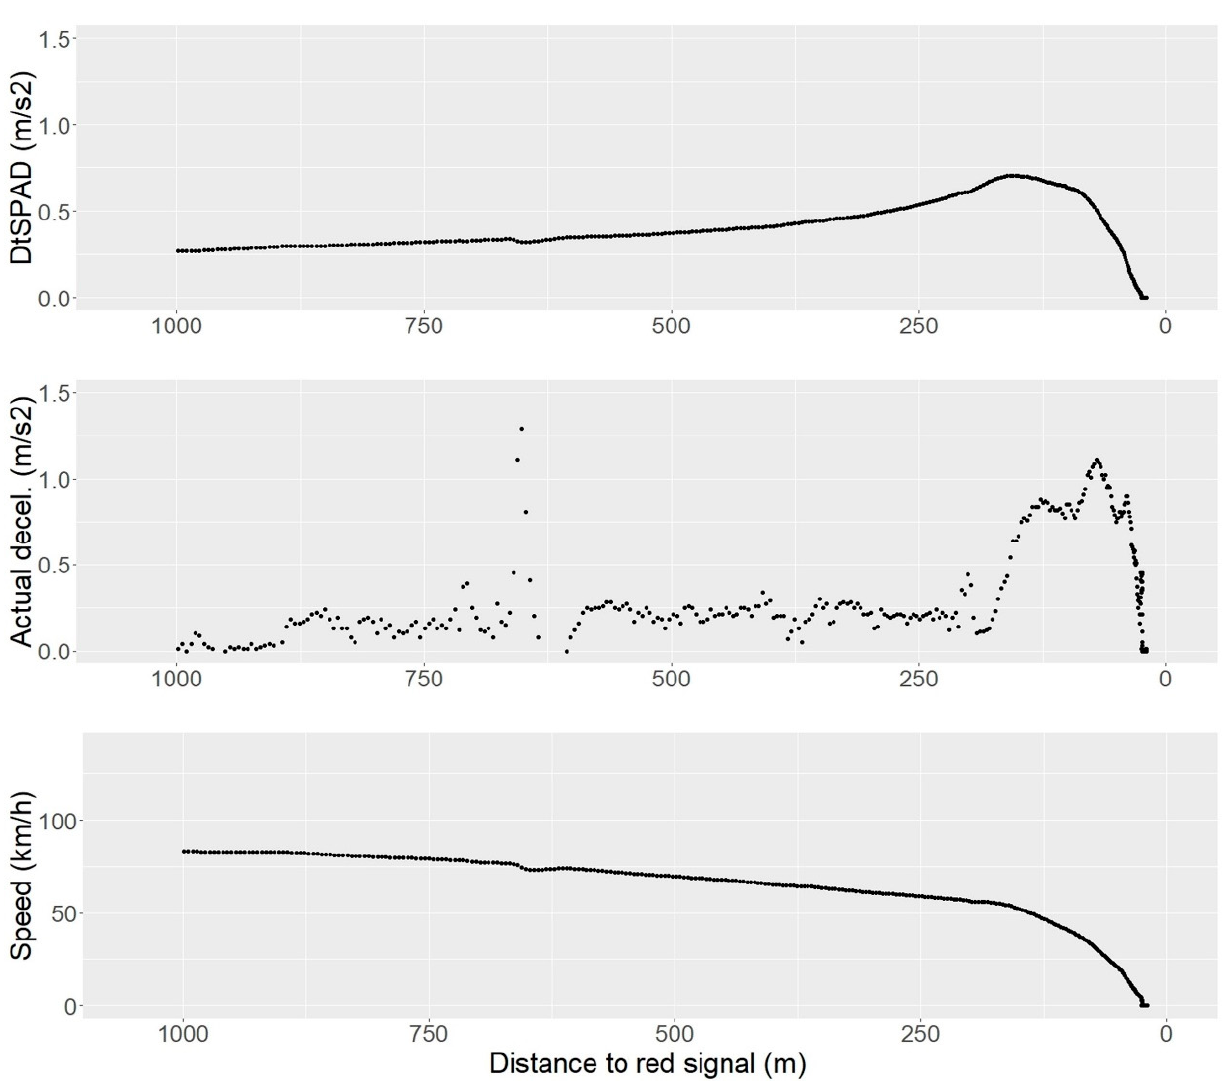
Figure 11. The risk indicator deceleration to signal passed at danger (DtSPAD), clarified using three different cross sections of the same red aspect approach. (top) Risk indicator over distance in meters (m). The DtSPAD reaches its maximum value at 152 m before the red signal. (middle) Actual deceleration in meters per squared second (m/s 2 ) over distance. The DtSPAD declines once the actual deceleration is higher than the DtSPAD. (bottom) Speed in kilometer per hour (km/h) over distance graph.